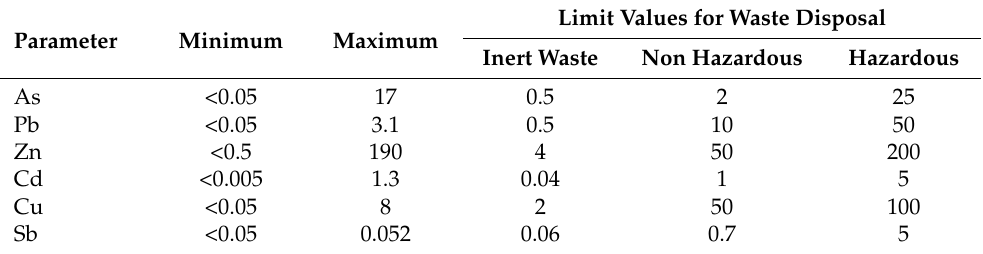
Table 2. Acid generation potential. Acid Base Accounting (ABA) tests for the soil samples from the old arsenopyrites concentrate storage area (former METBA plot) before remediation . Parameter.